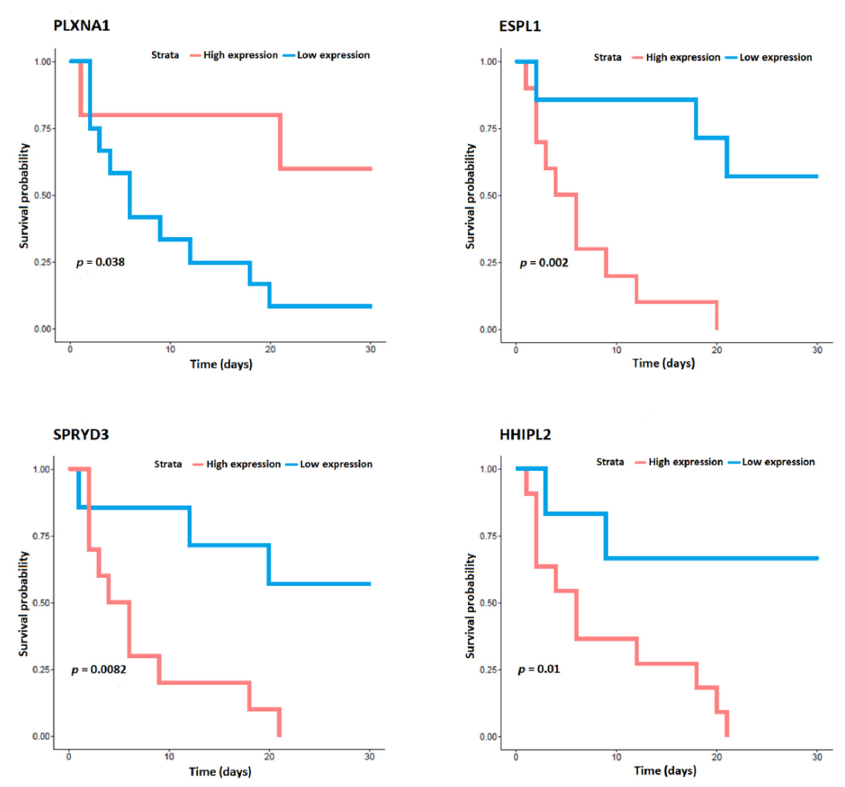
Figure 2. Analyses of the expression data for the genes SPRYD3 , ESPL1 , HHIPL2 , and PLXNA1 and Figure 2 . Analyses of the expression data for the genes SPRYD3, ESPL1, HHIPL2, and PLXNA1 and for survival in CAP for survival in community-acquired pneumonia patients. patients.